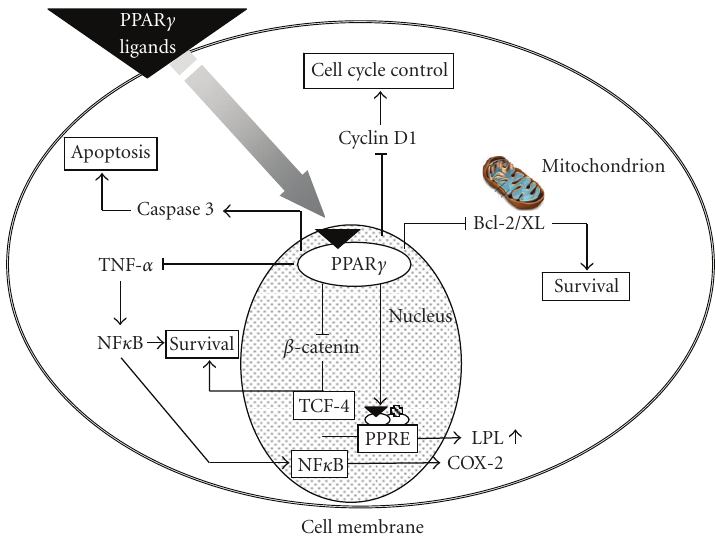
Figure 3: Molecular mechanisms for anticarcinogenic and/or chemopreventive e ff ects of PPAR γ ligands.